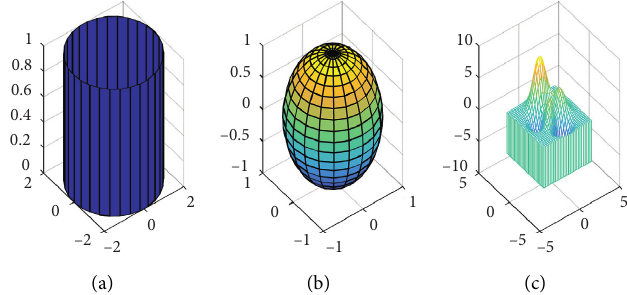
Figure 10: Experimental results of considering the difference in